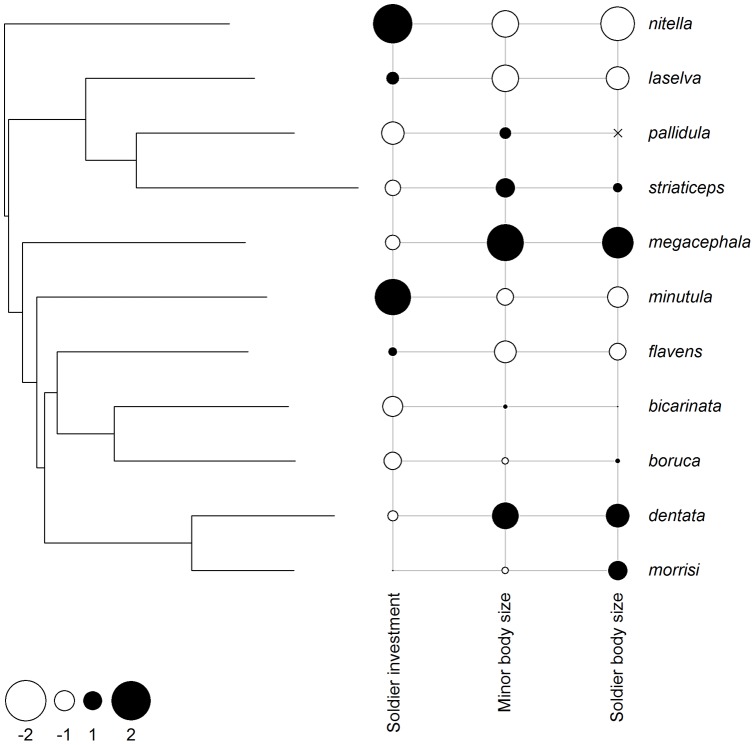
Proportional investment in soldiers, minor worker body size and soldier body size mapped on to the Pheidole phylogeny.Traits are scaled and centered, with filled circles representing values above the mean trait value and open circles representing values below the mean trait value. Larger circles indicate greater distance from the mean trait value. “×” indicates trait data not available. Mean trait values are reported when data from multiple populations of a single species were available.